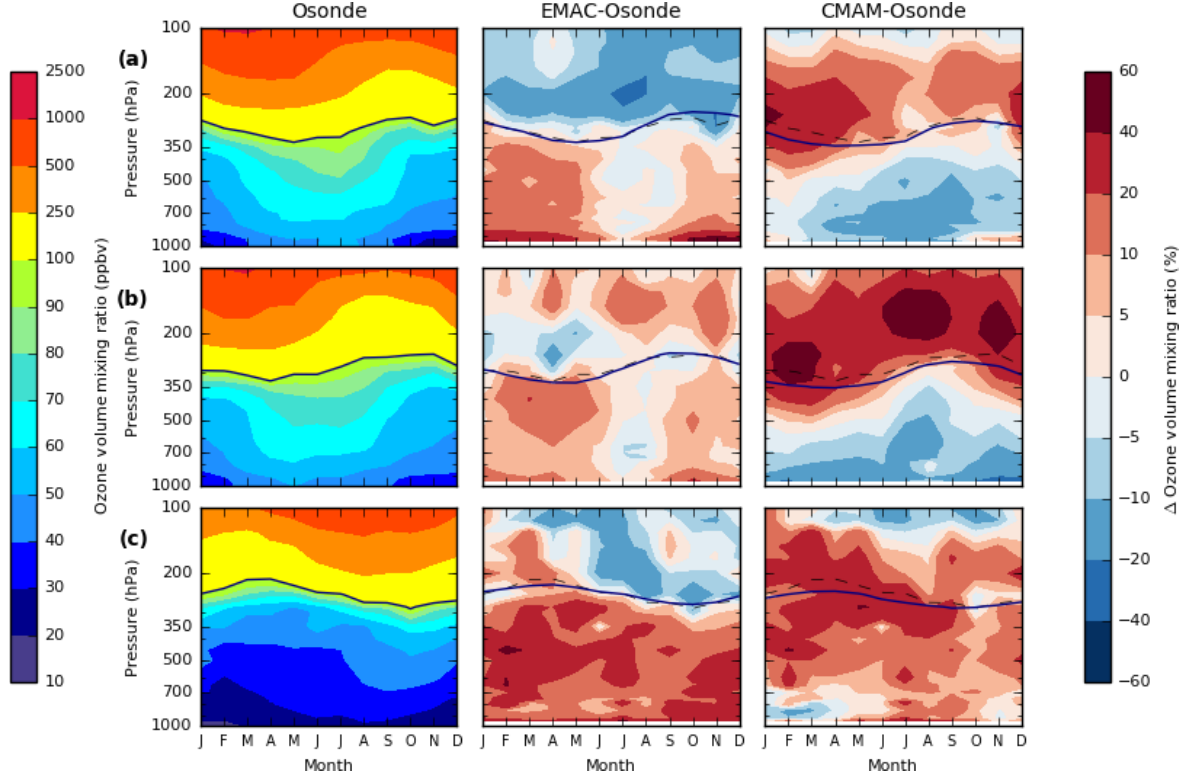
Figure 4. Monthly evolution of the vertical distribution of mean O 3 VMR (ppbv) derived from ozone-sonde measurements (left column); EMAC minus ozone-sonde differences (%) (middle column) and CMAM minus ozone-sonde differences (%) (right column) over the period 1980–2010 inclusive for three different world regions: (a) Europe ( n = 18), (b) eastern North America ( n = 14) and (c) the Tasman Sea ( n = 6). The ozone-sonde–model 100ppbv contour is additionally highlighted in bold (ozone-sonde 100ppbv contour indicated again by dashed line – middle and right